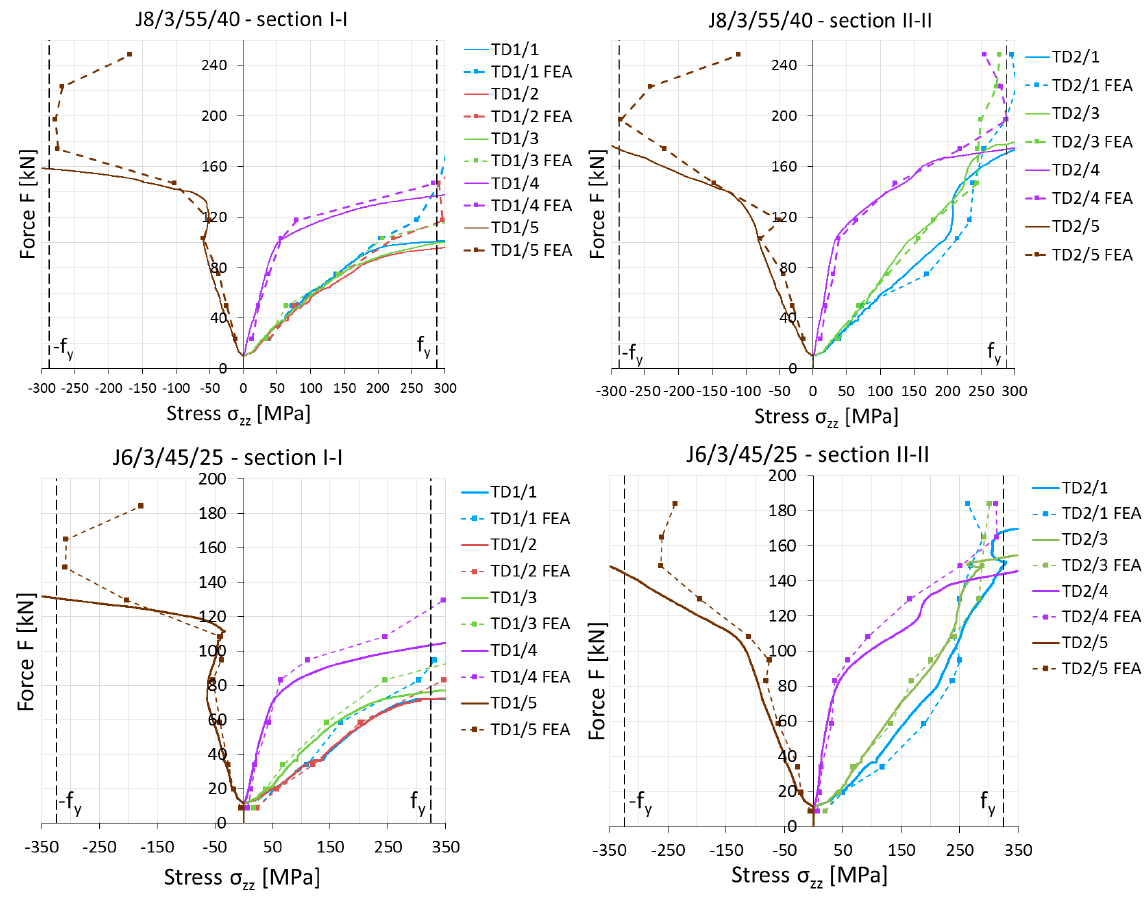
Figure 11. Comparison of longitudinal stress σ zz values obtained from experimental tests and numerical simulations for example elements.